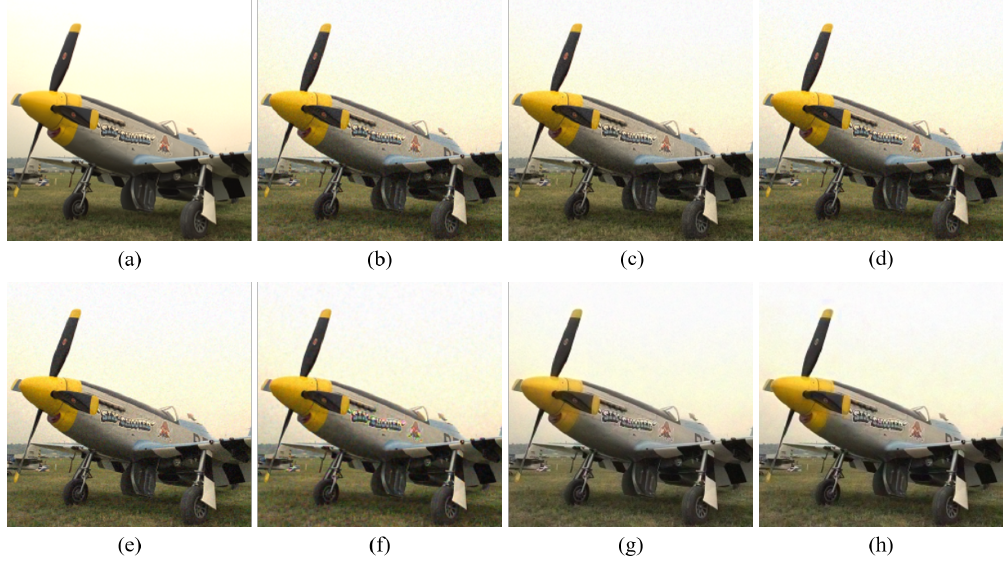
Figure 8. Demosaicing results of the Kodak No. 20 image under low-noise condition. ( a ) Original ( b )